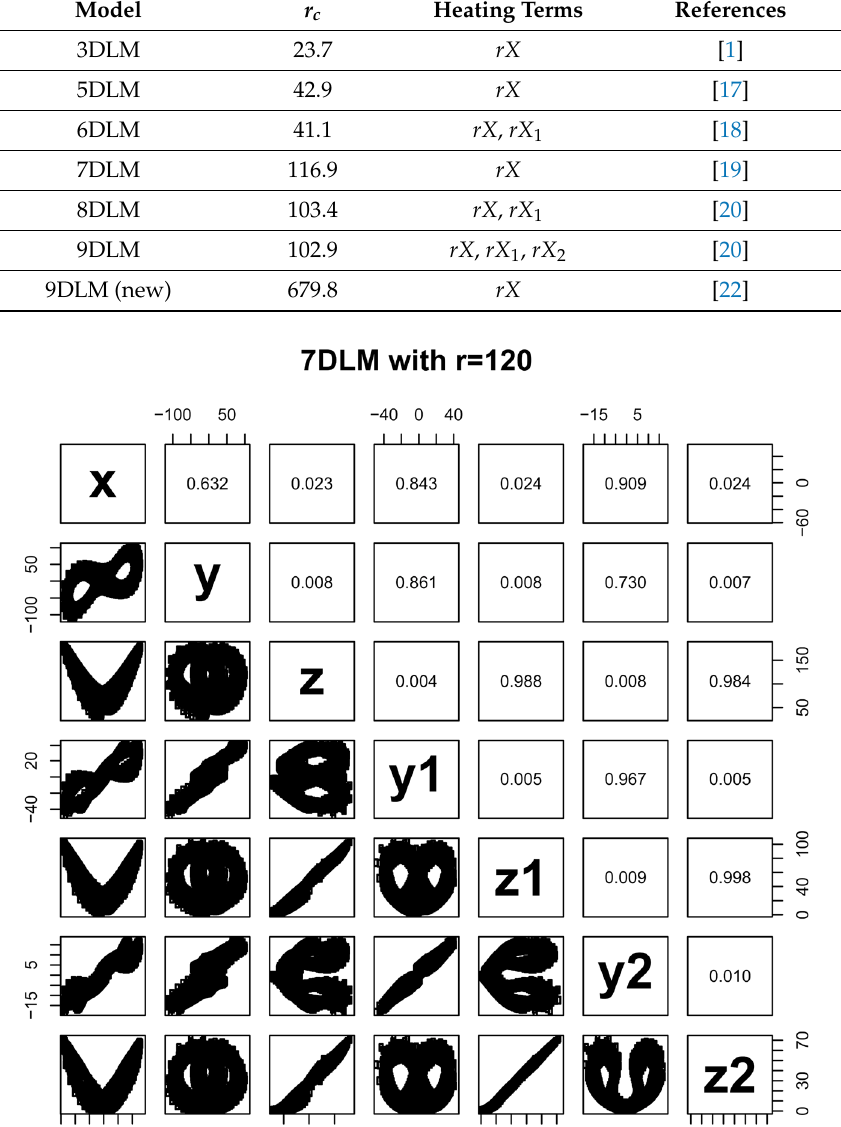
Table 2. The characteristics of various Lorenz models. Values for r c are determined based on analyses of the ensemble Lyapunov exponents [17,51]. The “Heating terms” column indicates heating terms within the corresponding LM.